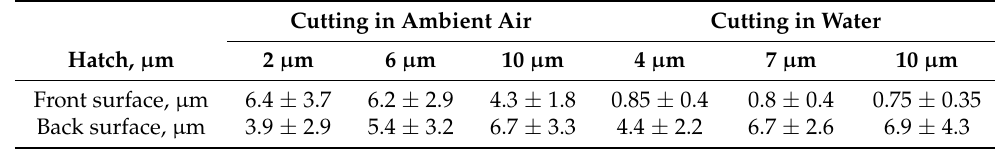
Table 2. Average chipping widths.